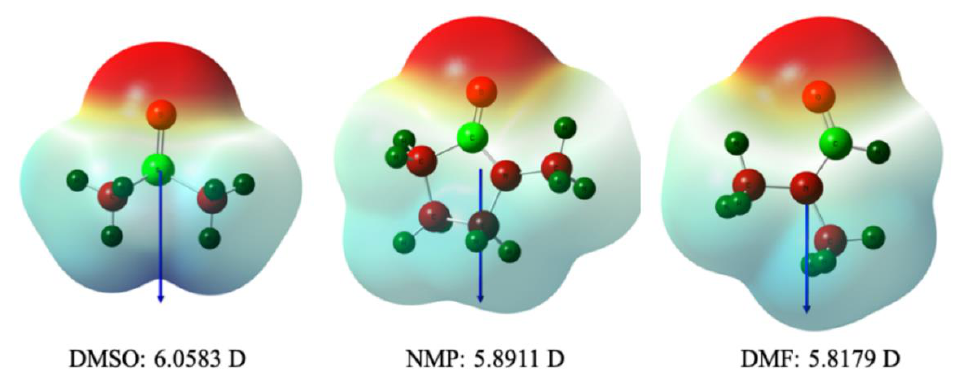
Figure 3. Dipole moments of three polar aprotic solvents.